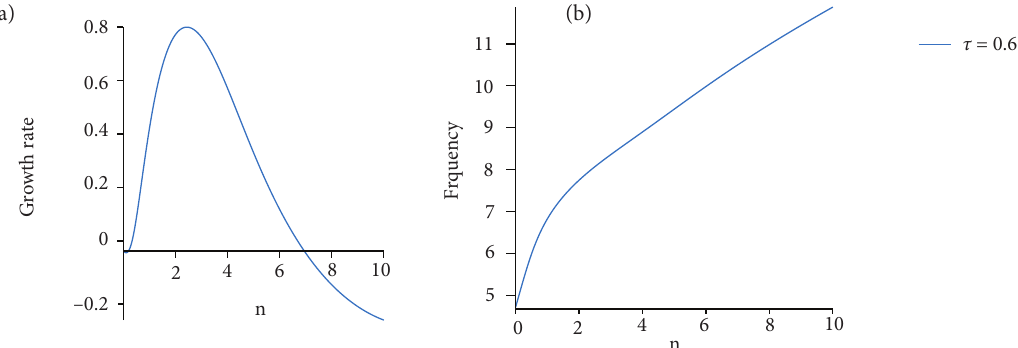
Figure 4. Nominal thermoacoustic characteristics for duct (3L mode) showing (a) growth rate and (b) frequency.